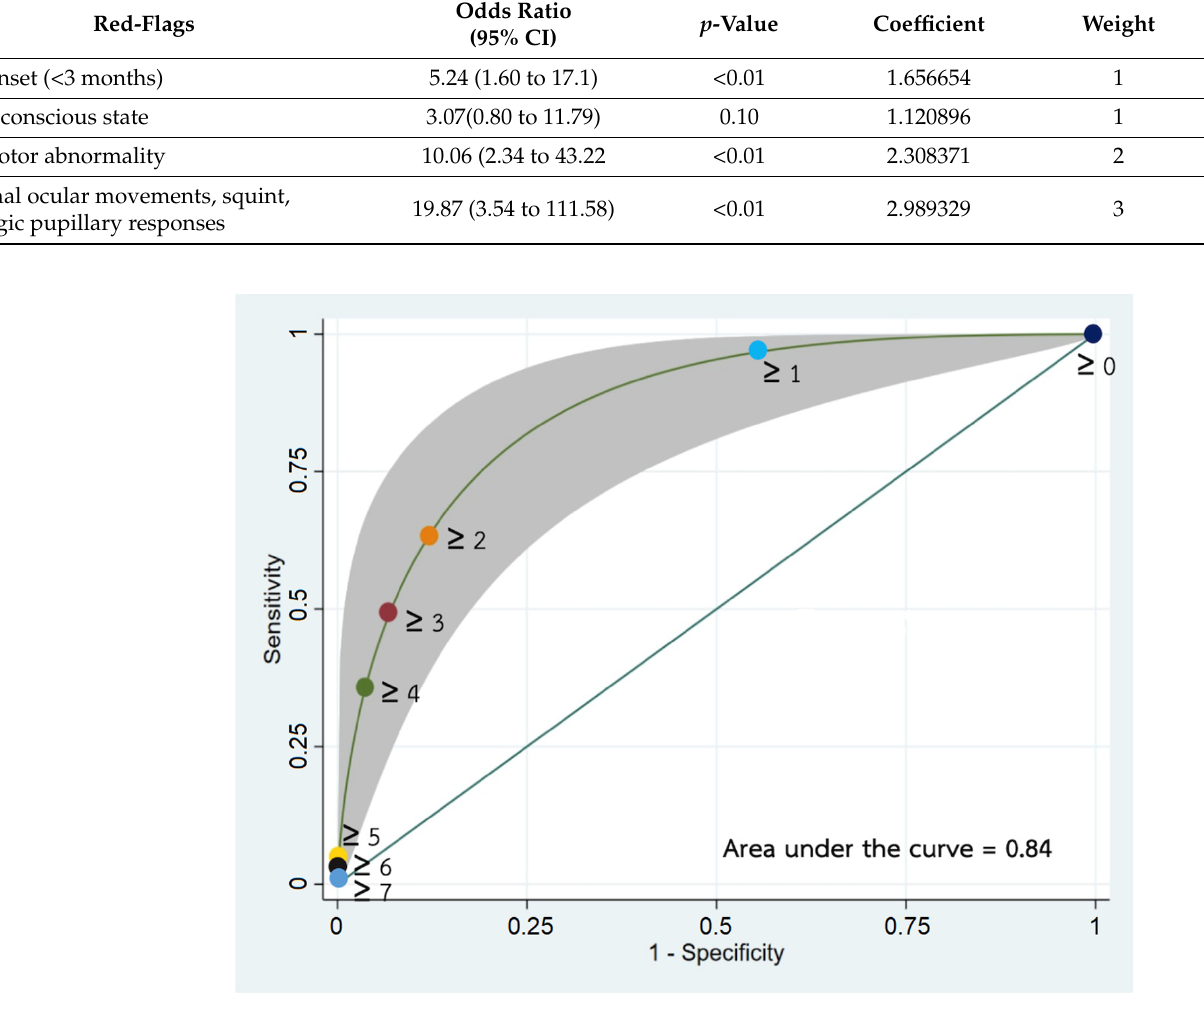
Figure 2. Area under the receiver operating characteristic curve (AuROC) of the proposed clinical predictor score. Table 5. Diagnostic accuracy of the clinical predictor